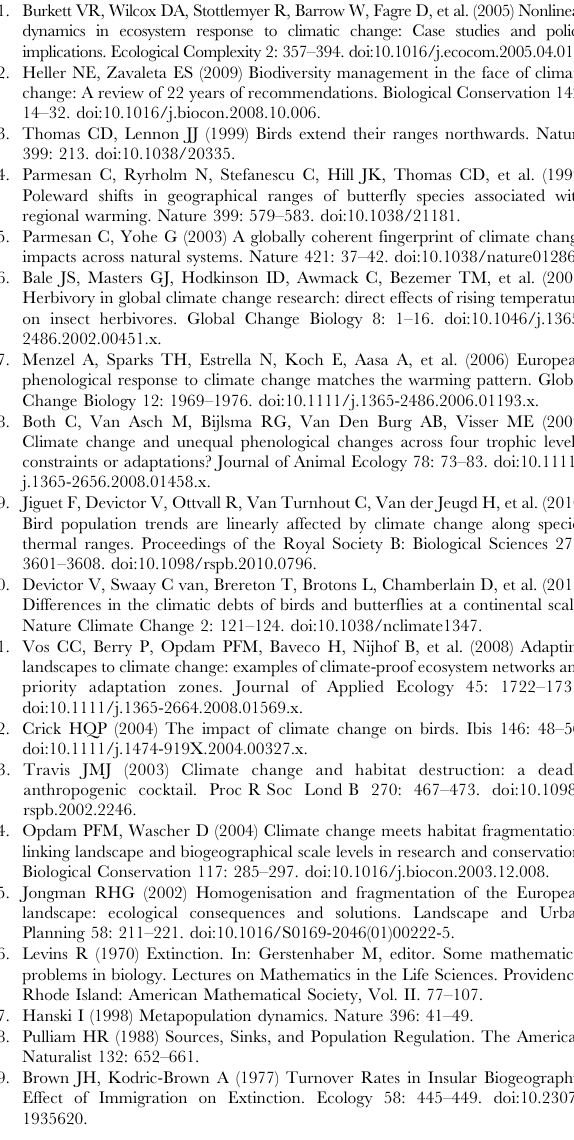
Table S5 Trends for years 1997–2011. Table S6 Relationship between colonisation and tem-